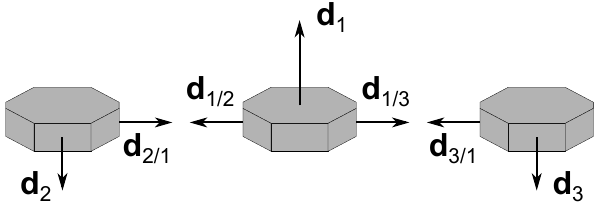
Figure 4. Example of an ambiguous